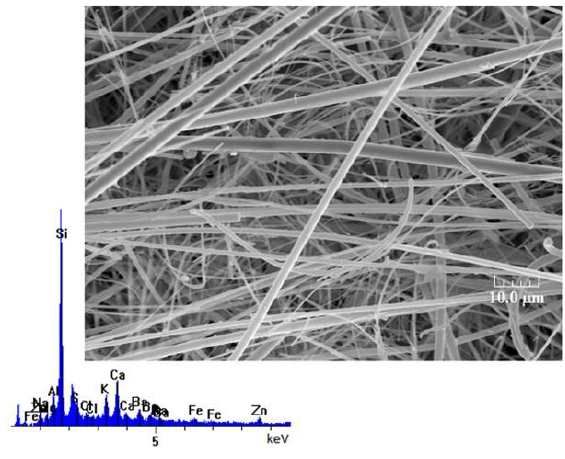
Figure 1. SEM image of an unused filter as a control and EDX